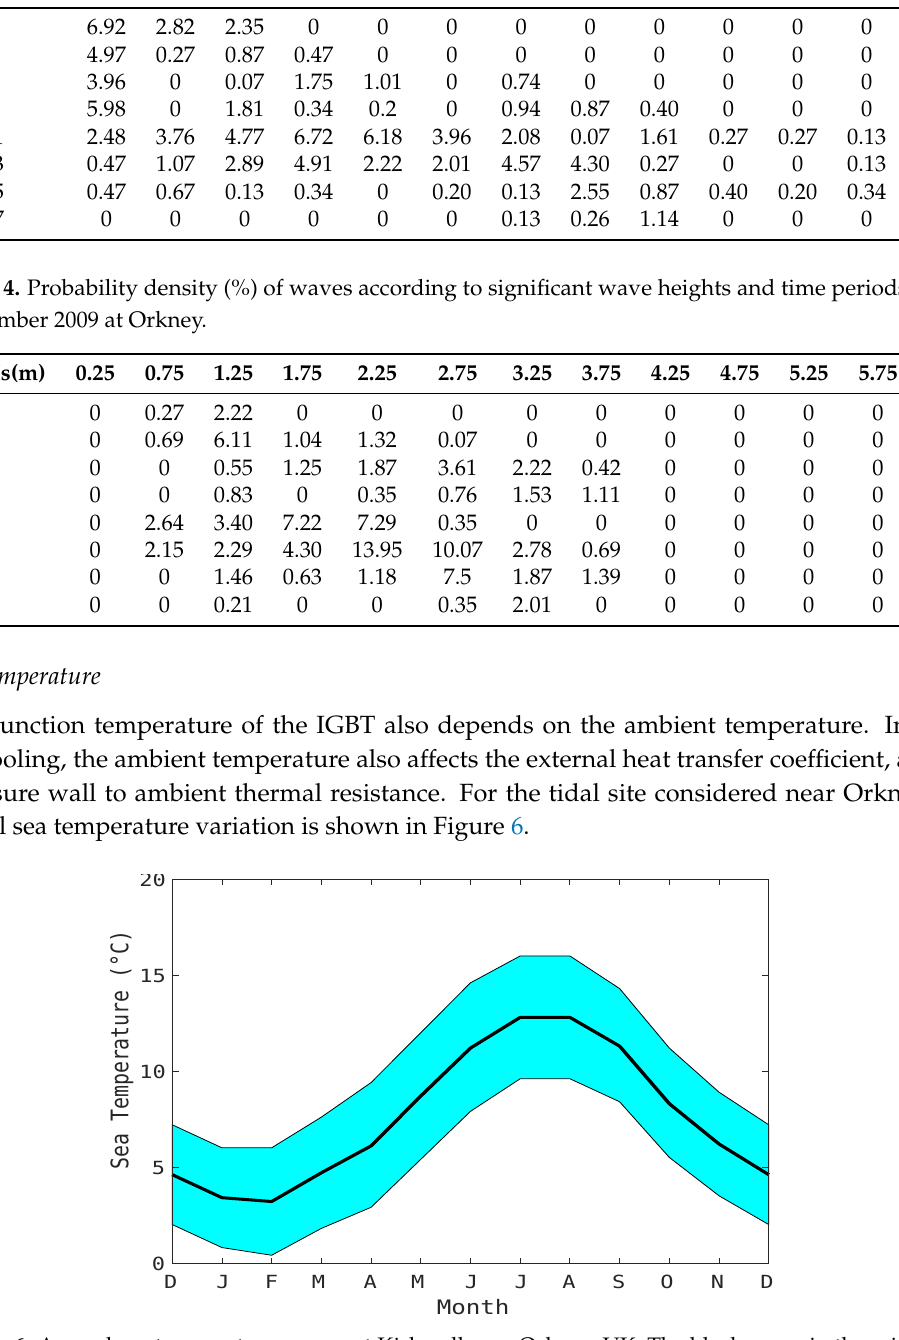
Figure 6. Annual sea temperature ranges at Kirkwall near Orkney, UK. The black curve in the middle of the shaded area represents the average temperature. Data source: Reference